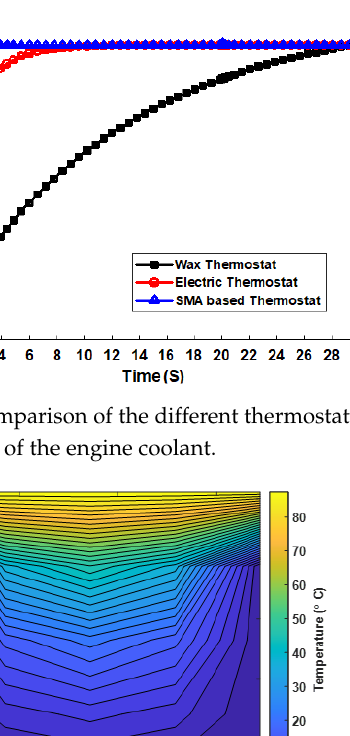
Figure 9. Heat fluctuations in the internal combustion engine.